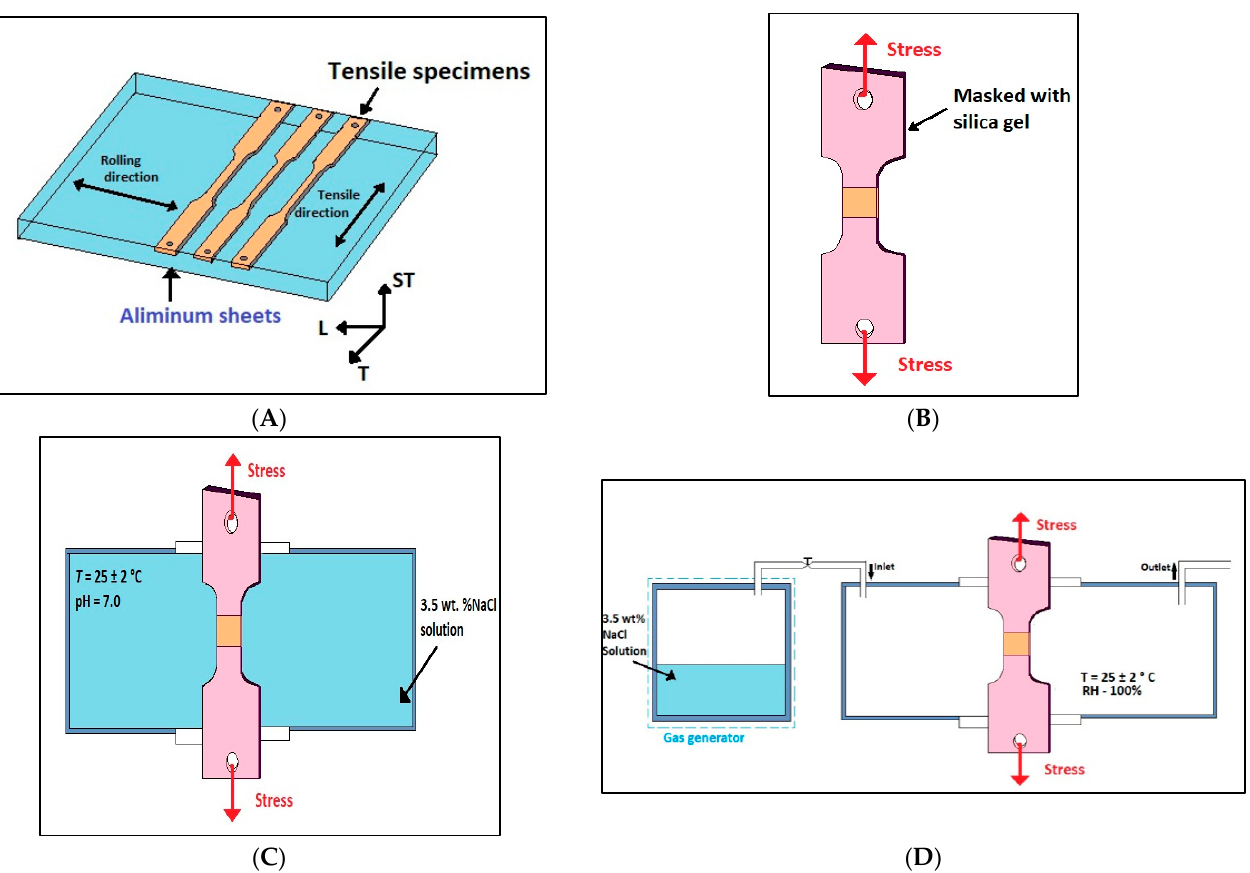
Figure 1. Schematic diagram of the sample processing ( A ) and preparation ( B ) for the SSRT tests, as well as the devices used in the tensile test for immersion in ( C ) air and ( D ) 3.5 wt% NaCl.